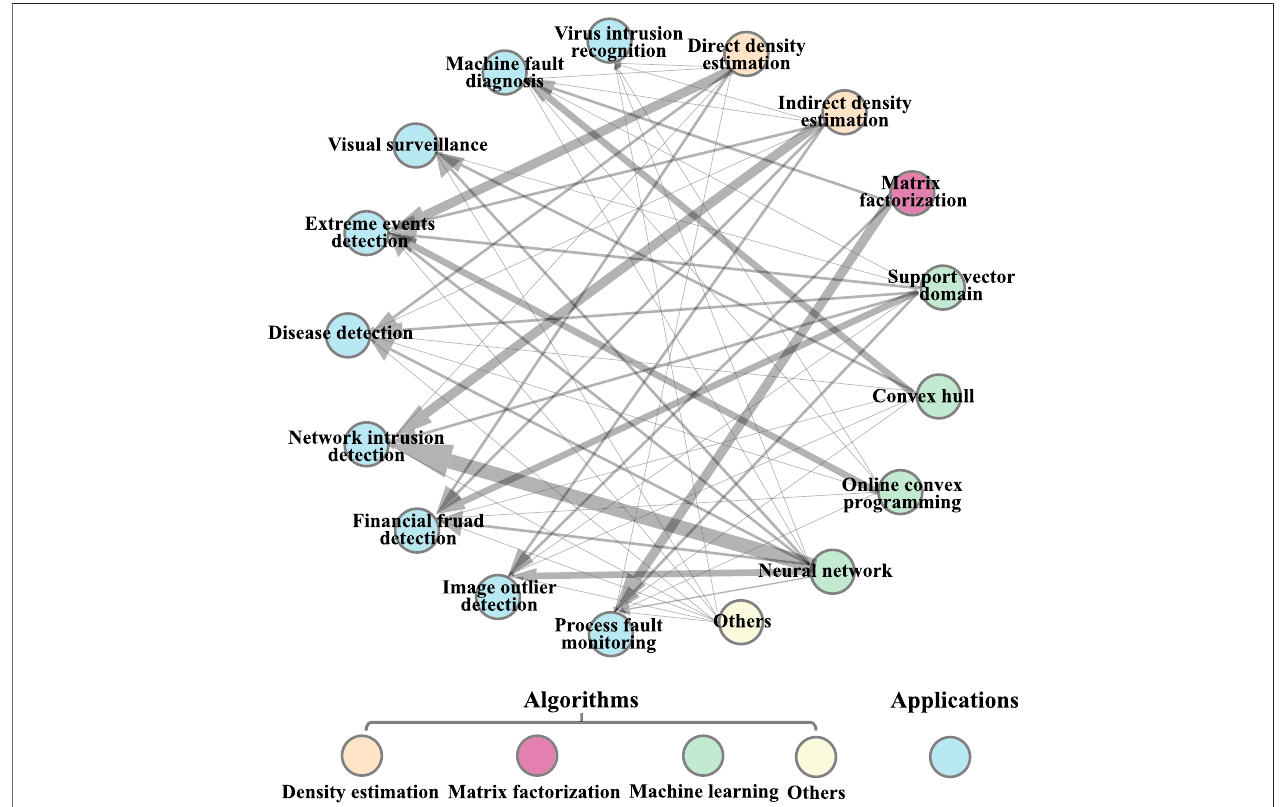
FIGURE 2 | Various applications of CA-based anomaly detection methods in different fi